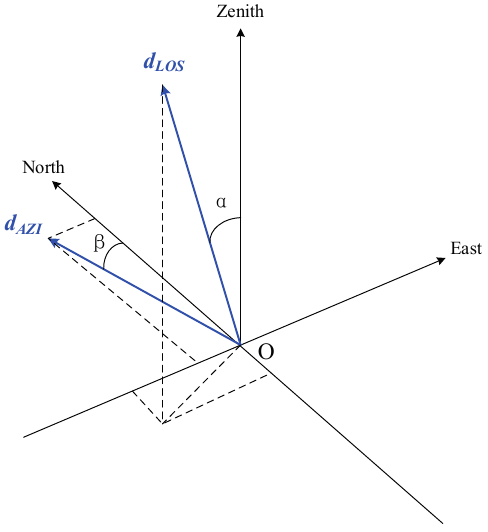
Figure 5. Monitoring vectors for line-of-sight (LOS) differential synthetic aperture radar interferometry (DInSAR) and azimuthal multiple-aperture synthetic aperture radar interferometry (MAI) in the ascending